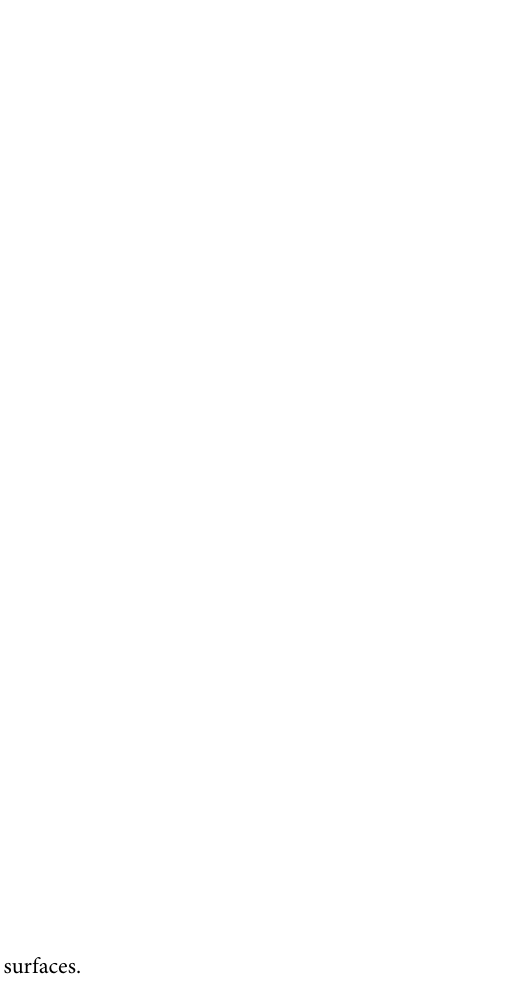
Table 2. Experimental design matrix with coded